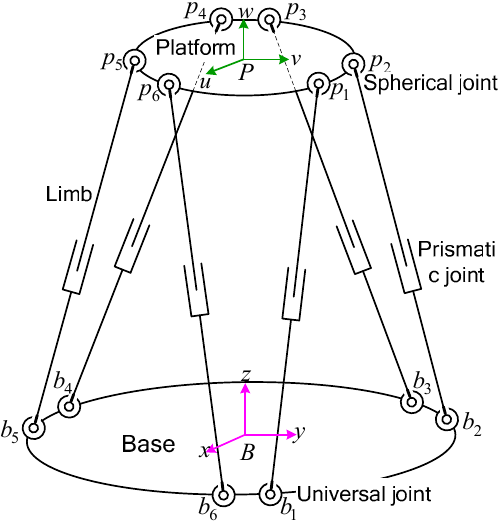
Figure 1. Schematic view of the Stewart platform.